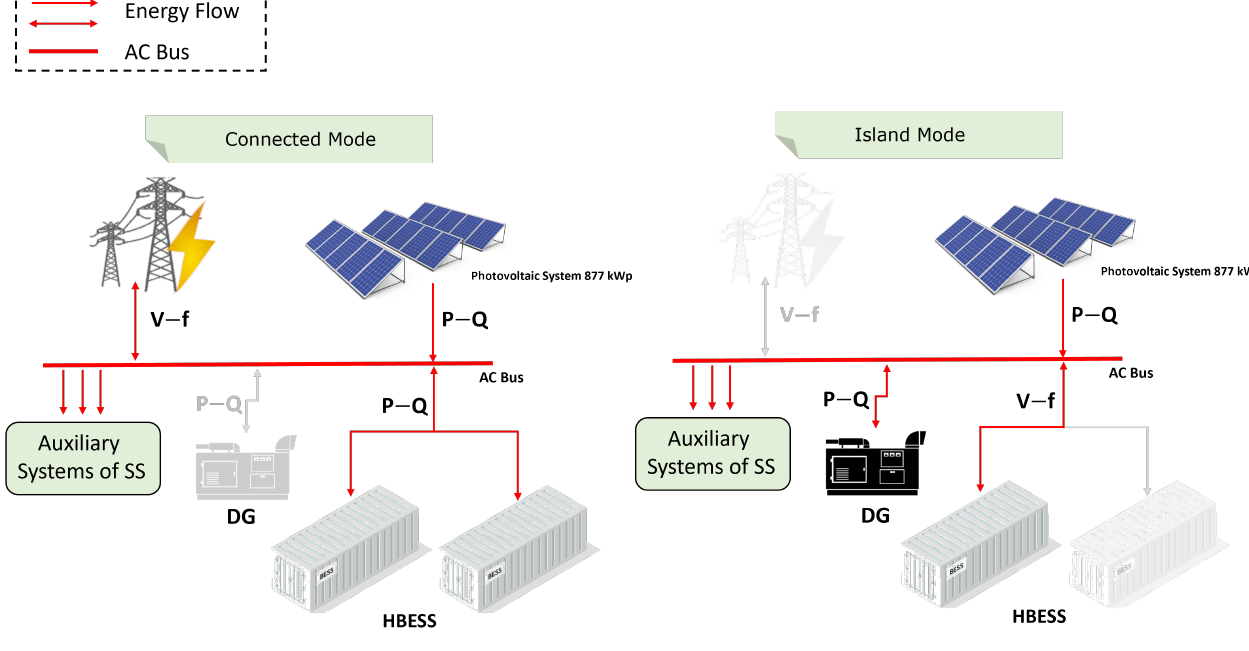
Figure 4. Operating modes (adapted from